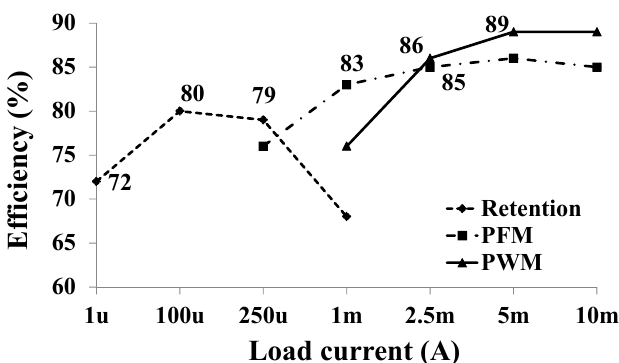
Figure 31. Measured e ffi ciency of the DC-DC buck converter in triple mode.